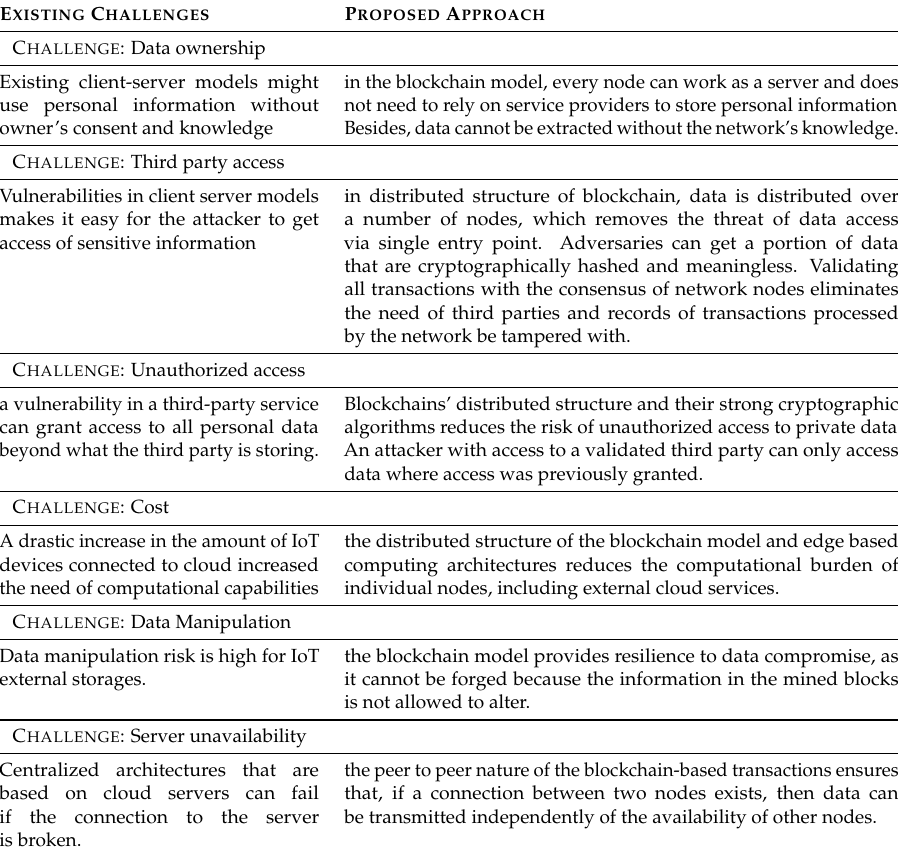
Table 1. Major challenges and problems in existing centralized infrastructure and description of how blockchain aids in overcoming these challenges. The challenges are summarized from the related works listed in this paper, mainly from